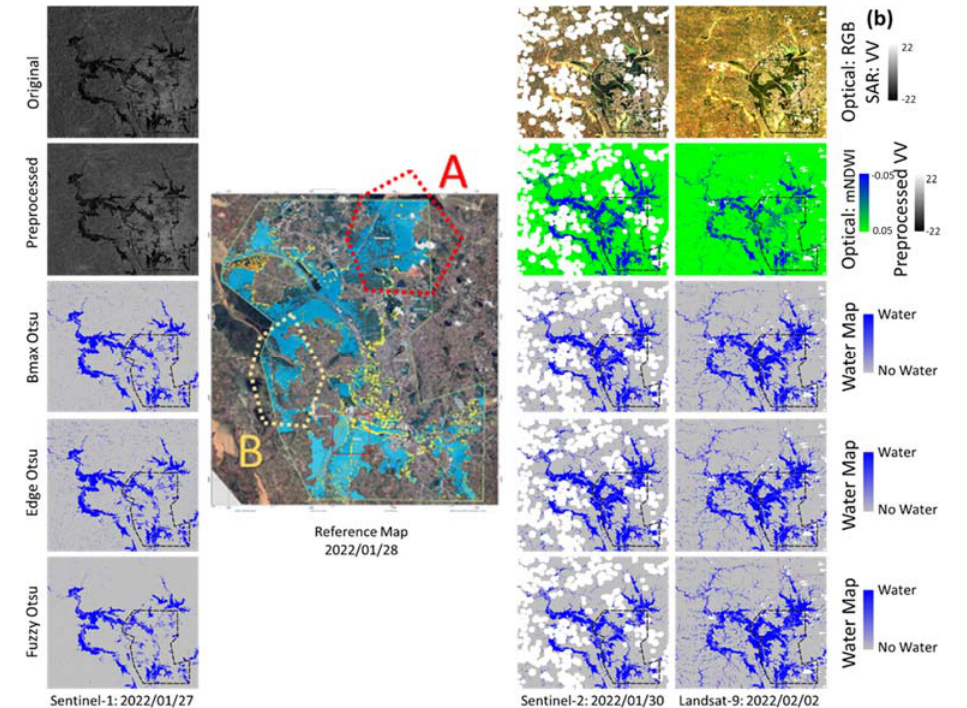
Figure 5. The satellite optical and SAR images, preprocessed VV and mNDWI images, and surface mapping in the study area for the period of ( a ) before the flooding event (22 December 2021–15 January 2022) and ( b ) after the flooding event (27 January 2022–2 February 2022). The flood reference map of 28 January 2022 is included in ( b ), with flooded areas indicated by A and B.